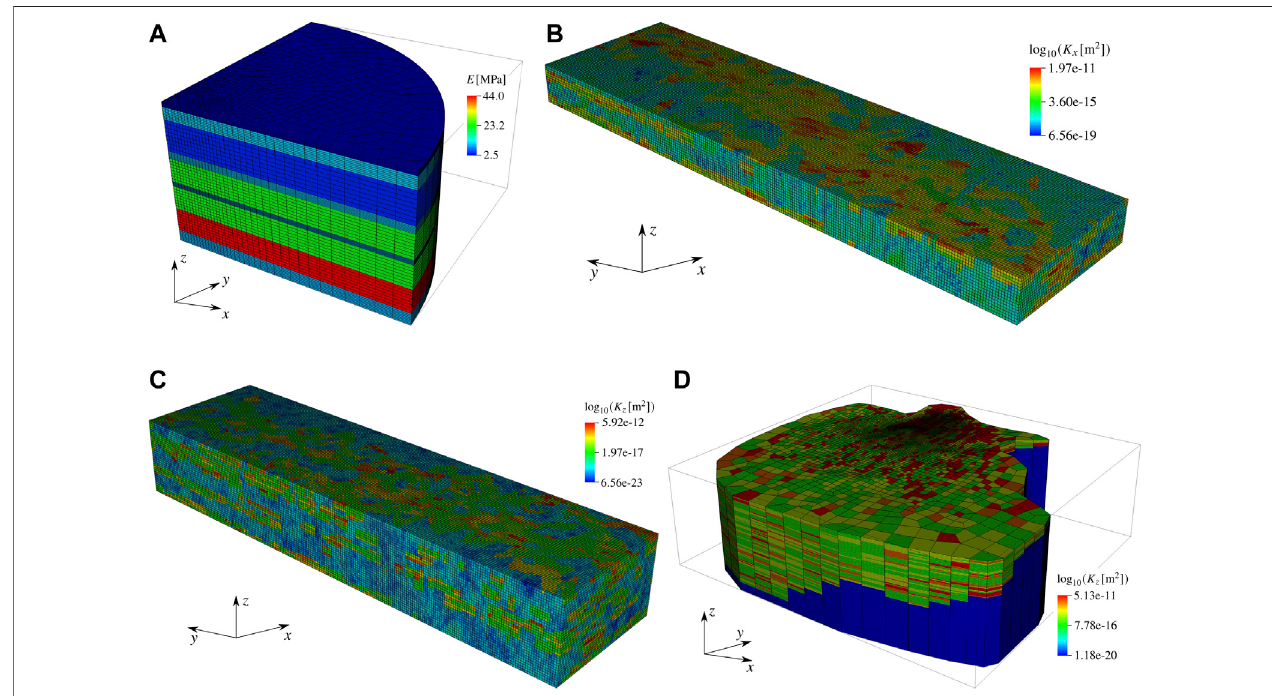
FIGURE 2 | Meshes used for the numerical test cases. (A) Treporti case, showing the values of Young modulus. (B) SPE10-16, with the horizontal intrinsic permeability distribution κ x = κ y . (C) SPE10-35, displaying the vertical intrinsic permeability distribution κ z . (D) Chaobai case, showing the vertical intrinsic permeability distribution K z . For Chaobai, a vertical exaggeration factor of 25 is used.